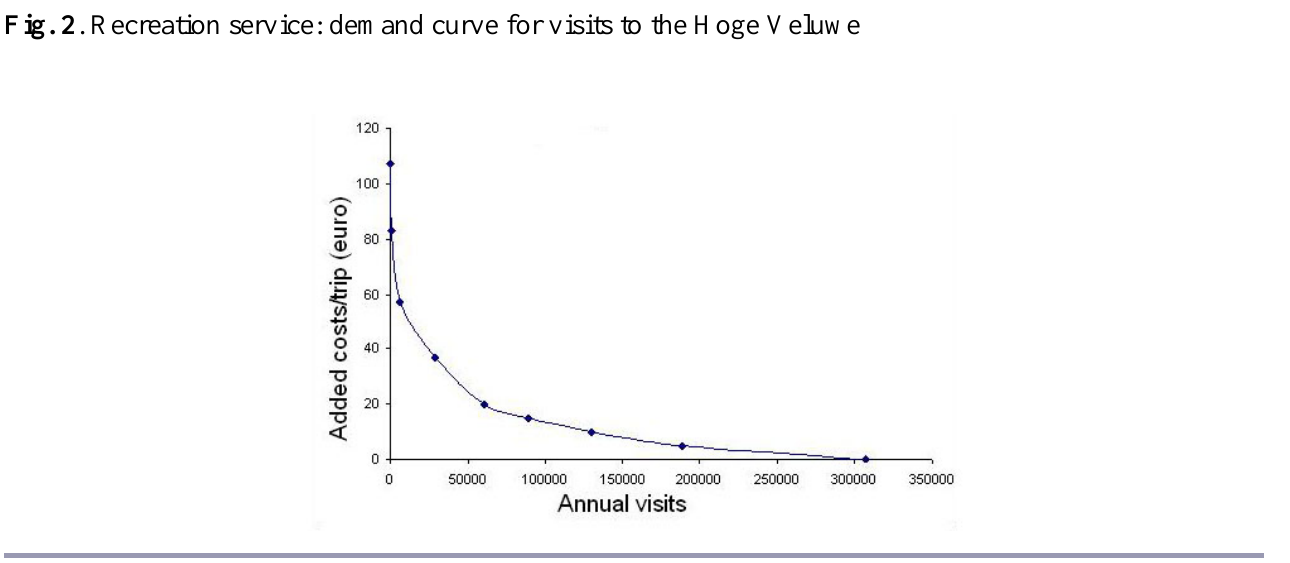
Fig. 2 . Recreation service: demand curve for visits to the Hoge